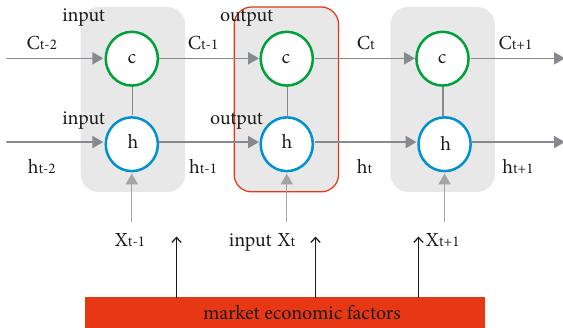
Figure 3: The workflow of LSTM method.